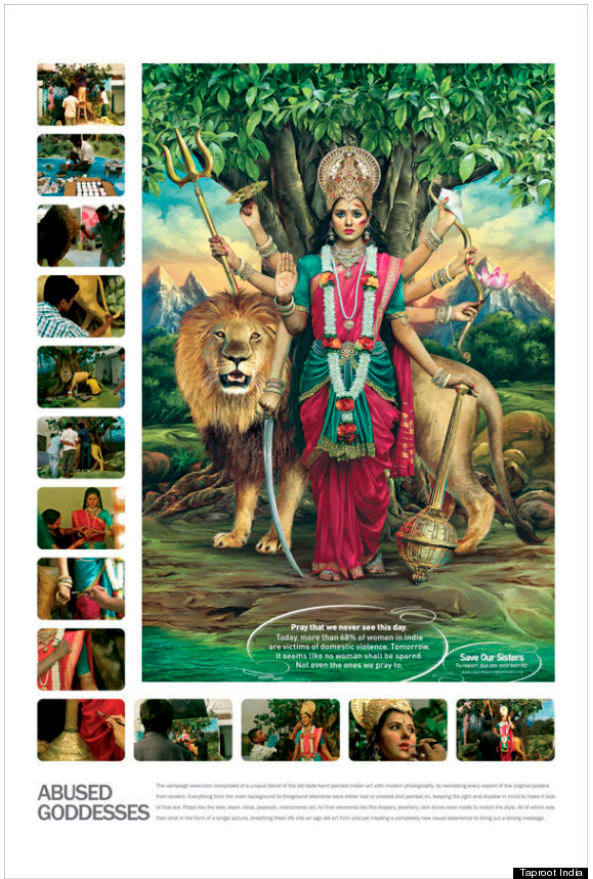
Figure 4. One poster (of three) from the Abused Goddesses campaign depicting the goddess Durga. Image Courtesy: Taproot Dentsu.